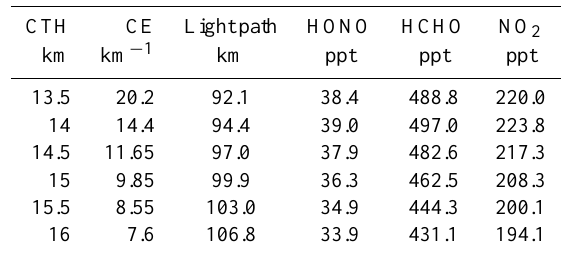
Table 4. Length of the light path and averaged mixing ratios of HONO, HCHO and NO 2 inside the cloud. CTH